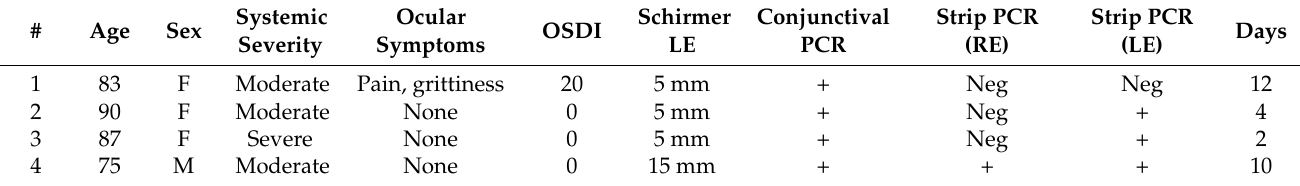
Four (7.1%) of the 56 conjunctival swab samples tested positive for SARS-CoV-2. Four (3.6%) of the 112 Schirmer strips were positive for SARS-CoV-2. In the four patients with positive conjunctival swab samples, Schirmer strip samples were negative in both eyes in one patient, positive only in the left eye in two patients and positive in both eyes in one patient. None of the patients had a negative conjunctival swab and a positive Schirmer strip sample. The characteristics of the patients with positive ocular samples are provided in Table 1. No association was found between the RT-PCR test from ocular samples and ocular symptoms. Twenty-nine percent of patients with a negative RT-PCR and 25% of patients with positive ocular RT-PCR had ocular symptoms ( p = 0.679). Three of the patients had moderate illness and one presented a severe course of the disease. Cycle threshold (Ct) values for each of the genes assayed (E, N, RdRP/S) are given in Table 2. The mean Ct values (E gene) were 31.2 (SD 5.0) in conjunctival swabs, 32.9 (SD 2.7) in left eye Schirmer strips and 24.2 (SD 8.2) in nasopharyngeal swabs. It must be noted that nasopharyngeal and ocular samples were not taken on the same day. Tear production (Schirmer test) was higher in right eyes (mean 12.0 mm, SD 8.7 mm) than in left eyes (mean 7.5 mm, SD 5.3). Overall, 17 (30.4%) patients presented ocular symptoms (grittiness, 16.1%; ocular pain, 7.1%; photophobia, 1.8%; blurred vision, 3.6%; conjunctival hyperemia, 3.6%; itching, 3.6%; secretion, 7.1%). Nine patients with moderate disease and eight with severe disease had ocular manifestations. The average score of the OSDI questionnaire was 4.9 points (SD 8.6, range 0–30). Table 1. Main characteristics of our four patients with positive conjunctival swab samples.